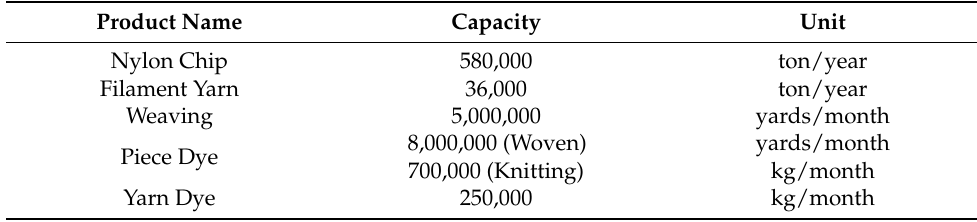
Table 3. Production capacity of the use